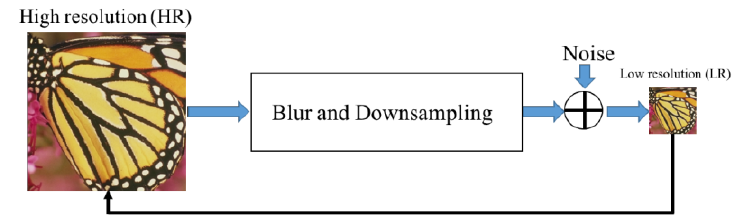
Figure 4. Block diagram of the single image super-resolution (SISR) problem [22].